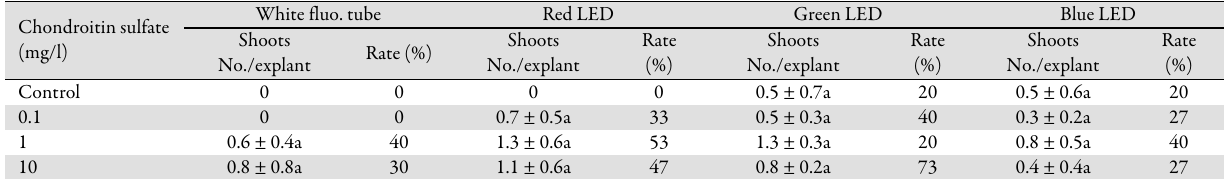
Table 5. In vitro growth of C. dayanum roots into different concentrations of chondroitin sulfate with modified MS medium, under four sources of lights White fluo. Chondroitin sulfate (mg/l)